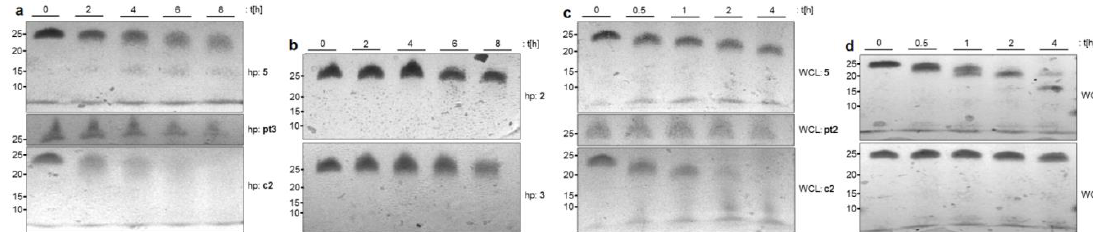
Figure 4. ( a , b ) Influence of human plasma (hp) on NAA-modified oligonucleotides 2 , 3 ( b ) and 5 ( a ) with controls c2 and pt3 . ( c , d ) Influence of whole cell lysate (WCL) on NAA-modified oligonucleotides 2 , 3 ( d ) and 5 ( c ) with controls c2 and pt2 . In the interest of clarity, the oligonucleotide ladder indicating the lengths of the oligomers is not displayed and has been replaced with labels on the left side of the gels.